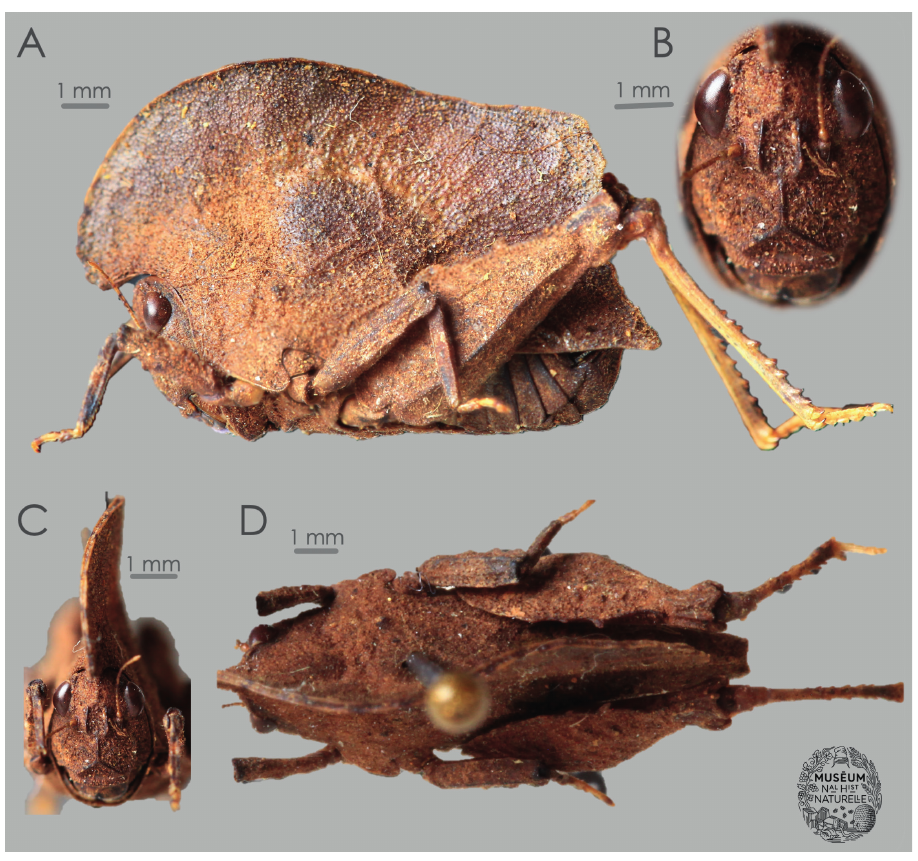
Figure 2. Valalyllum folium gen. et sp. nov. from Madagascar, male holotype, deposited in MNHN Paris. A habitus in left lateral view B head in frontal view C habitus in frontal view D habitus in dorsal view. Photo J. Skejo and MNHN